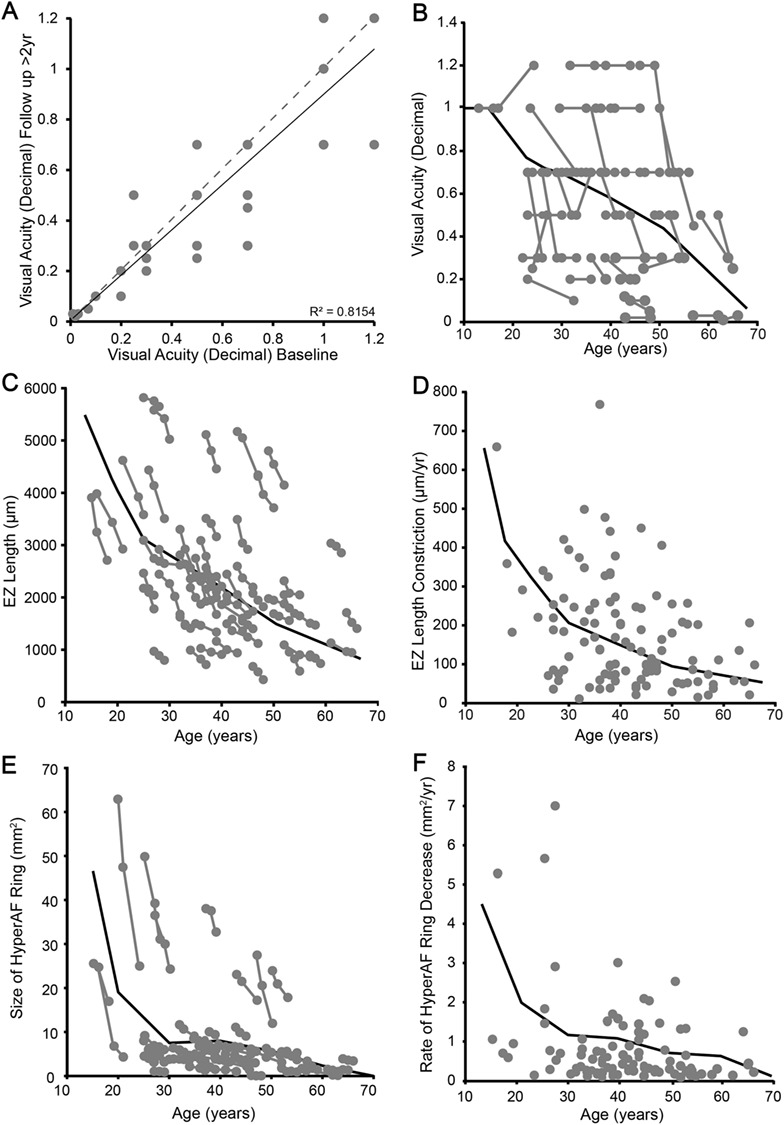
Visual acuity, EZ and hyperautofluorescent (hyperAF) ring measurements with age in USH2A patients. (A) and (B) Change in visual acuity over the observation period. (A) illustrates the change in BCVA between baseline and final follow up. The grey dashed line represents ‘no change’ while the black correlation line illustrates the subtle change. The measurement of each patient at each visit is depicted as a function of age in (B). (C) Correlation between EZ length and age. (D) EZ constriction rate (change in size divided by time between visits) as a function of age. Both (C) and (D) illustrate that the degeneration starts rapidly with later, slower decline. (E) and (F) illustrate the same changes in hyperAF ring area.